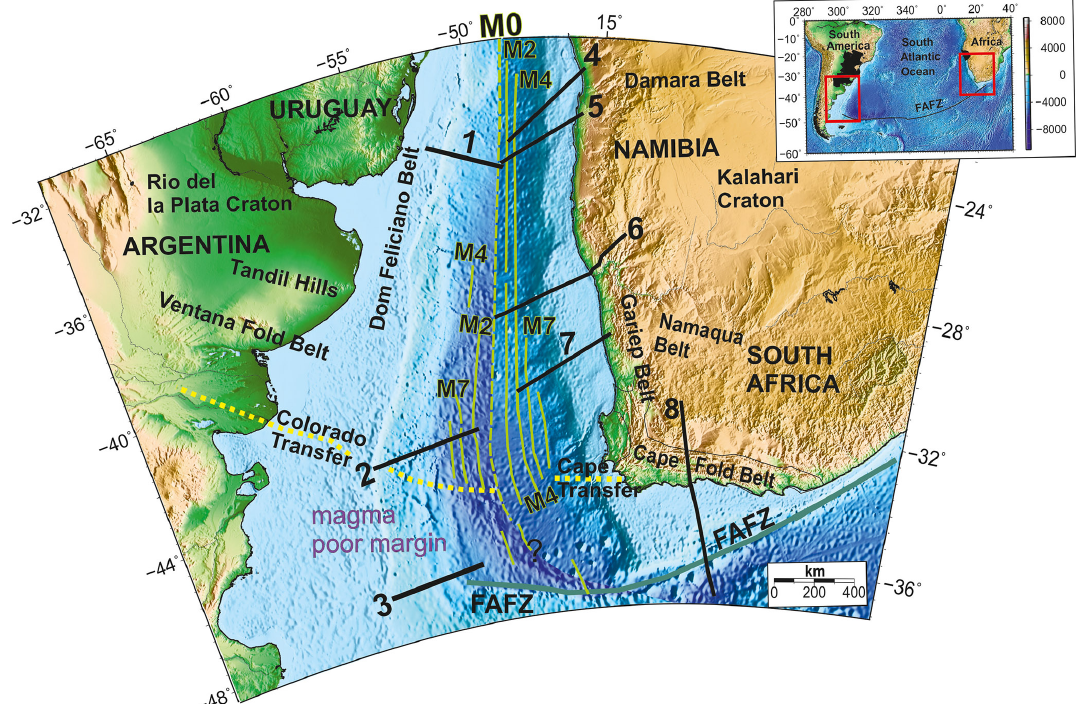
Figure 1. The southern South Atlantic Ocean aligned along magnetic seafloor-spreading anomaly M0 (dashed green line; ca. 125Ma). The continental margins between the Falkland–Agulhas Fracture Zone (FAFZ) and the Colorado–Cape transfer zone lack major magmatic extrusives and are indicated as magma-poor. The margins to the north of the transfer zone are volcanic rifted margins with extensive seaward- dipping reflector (SDR) wedges and high P -wave velocities in the lower crust. Black lines show the location of the refraction seismic lines discussed in the text: line 1 (BGR04-01), line 2 (BGR98-02), line 3 (BGR04-02), line 4 (Mamba 1), line 5 (Mamba 2), line 6 (Orange River), line 7 (Springbok) and line 8 (Agulhas–Karoo transect). Magnetic anomalies are shown as green lines.The inlay shows the present-day South Atlantic Ocean, with the black areas marking the distribution of the Paraná–Etendeka flood